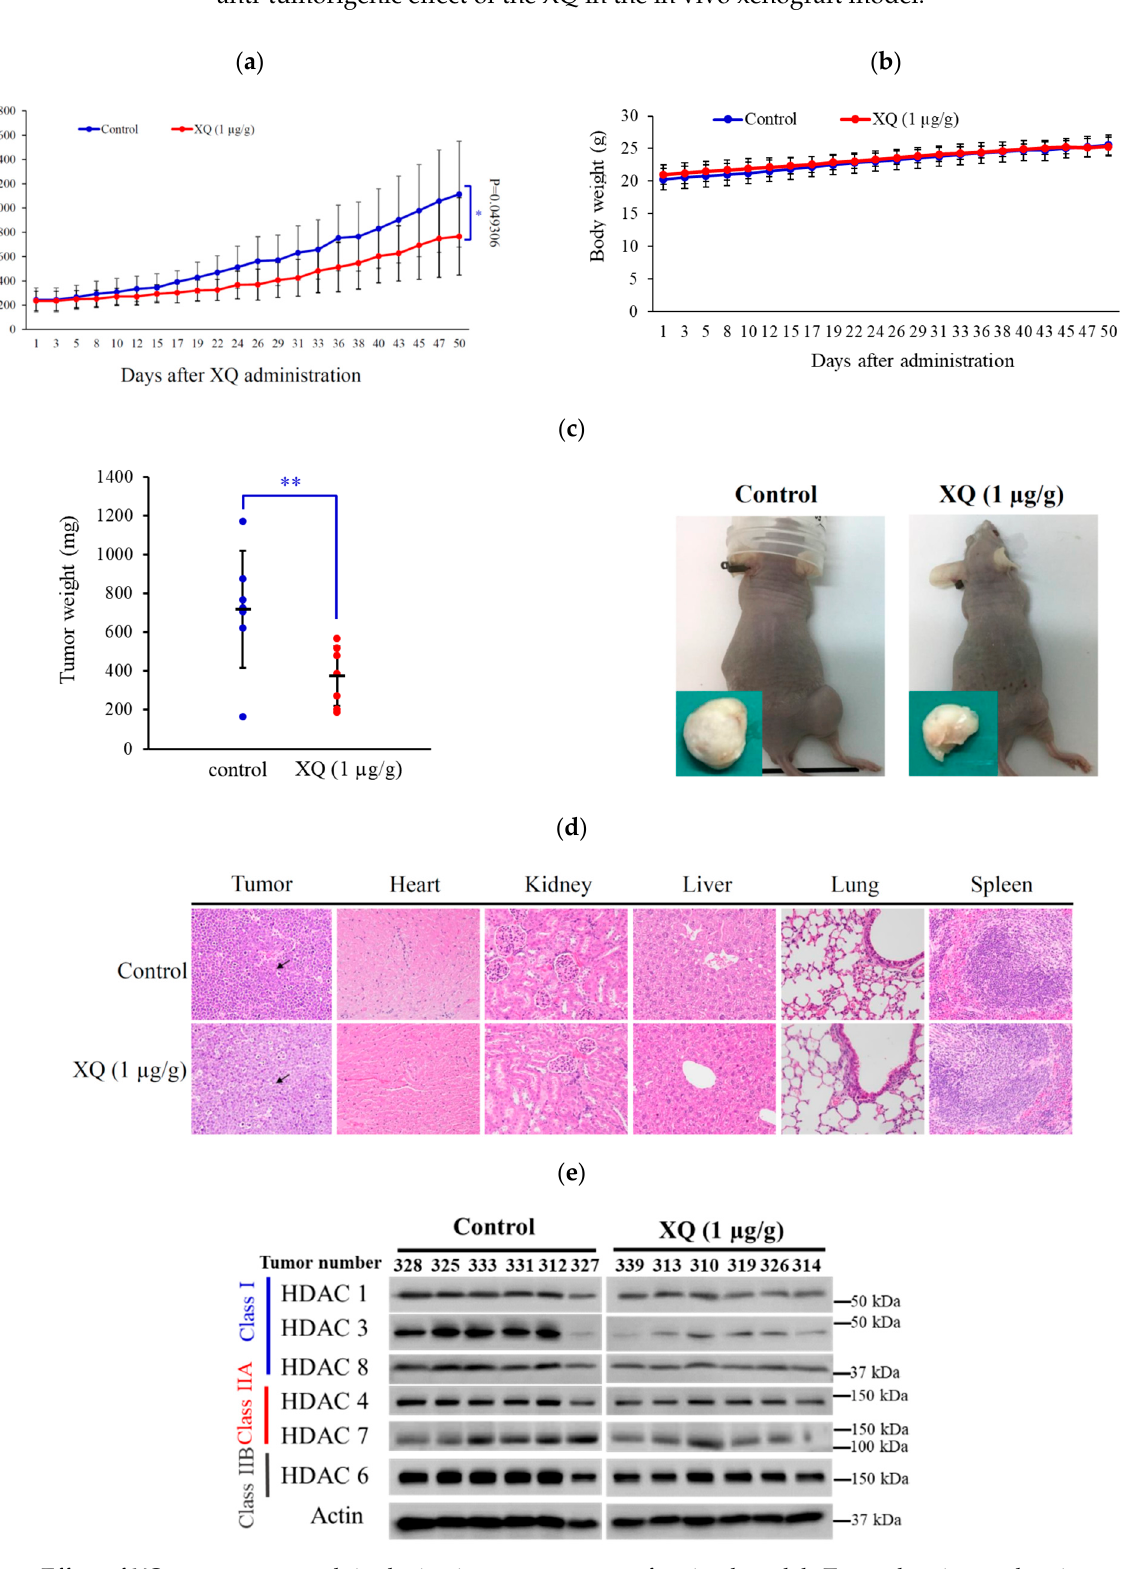
Figure 8. Effect of XQ on tumor growth in the in vivo tumor xenograft animal model. Tumor-bearing nude mice were intraperitoneally injected with the solvent control (DMSO, n = 7) and XQ (1 µ g/g, n = 7) for 50 days. ( a ) Tumor volumes